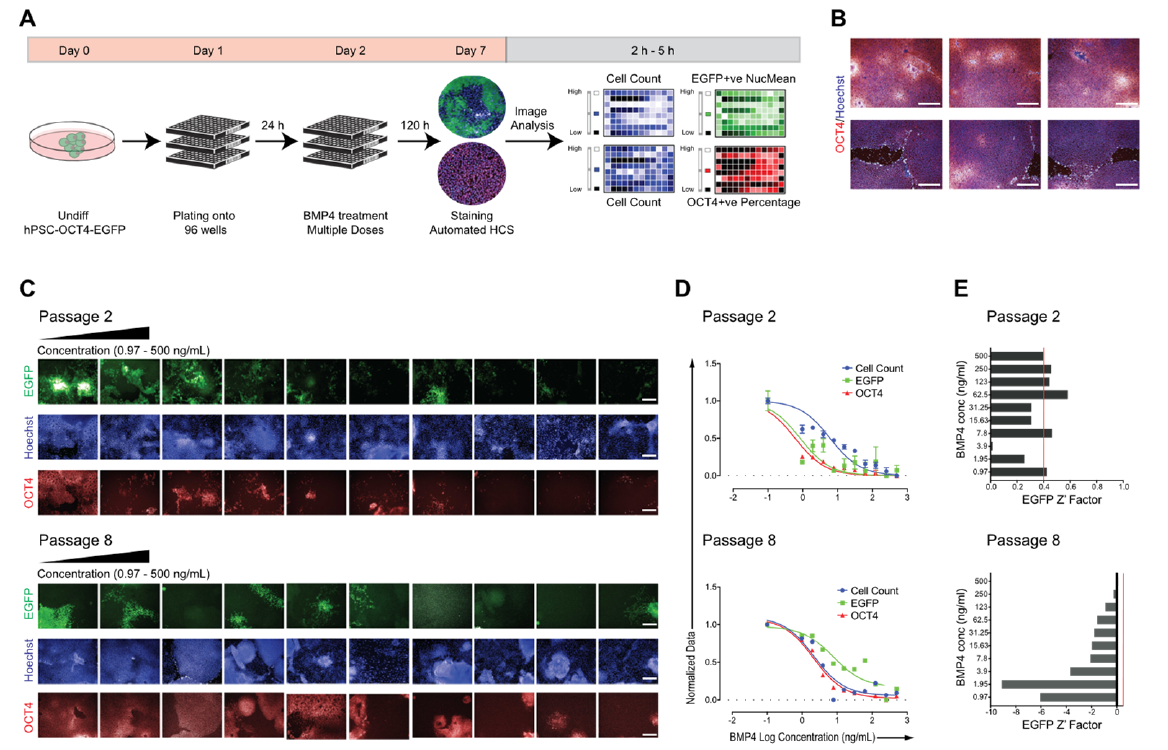
Figure 2. Adaption of hPSC–OCT4–EGFP for high-content screening. ( A ) Schematic representation of the BMP4 dose–response screen on hPSC–OCT4–EGFP. Undifferentiated colonies grown in mTeSR